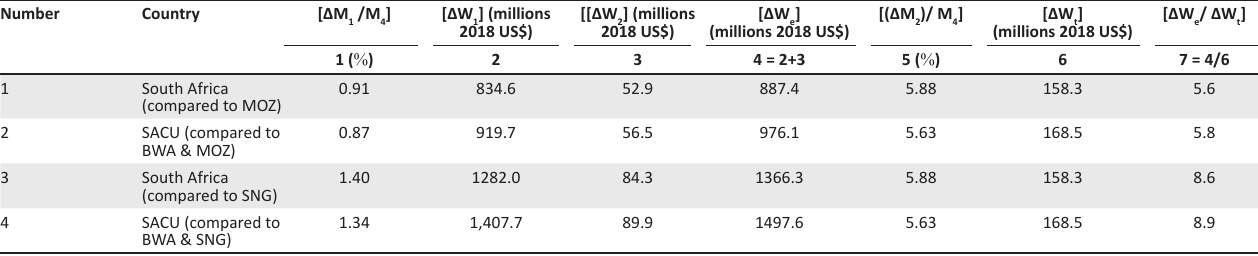
TABLE 4: Economic welfare effects of the total excessive compliance costs of import and tariff.